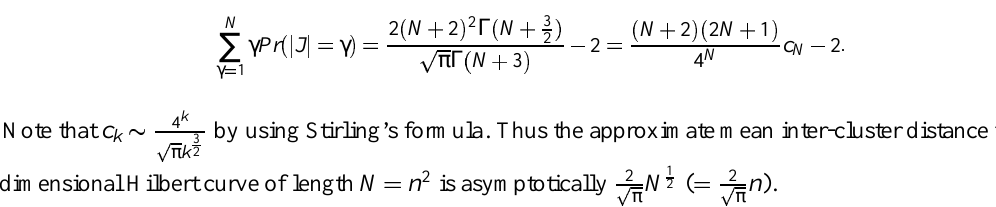
Fig. 2: Generation of H 2